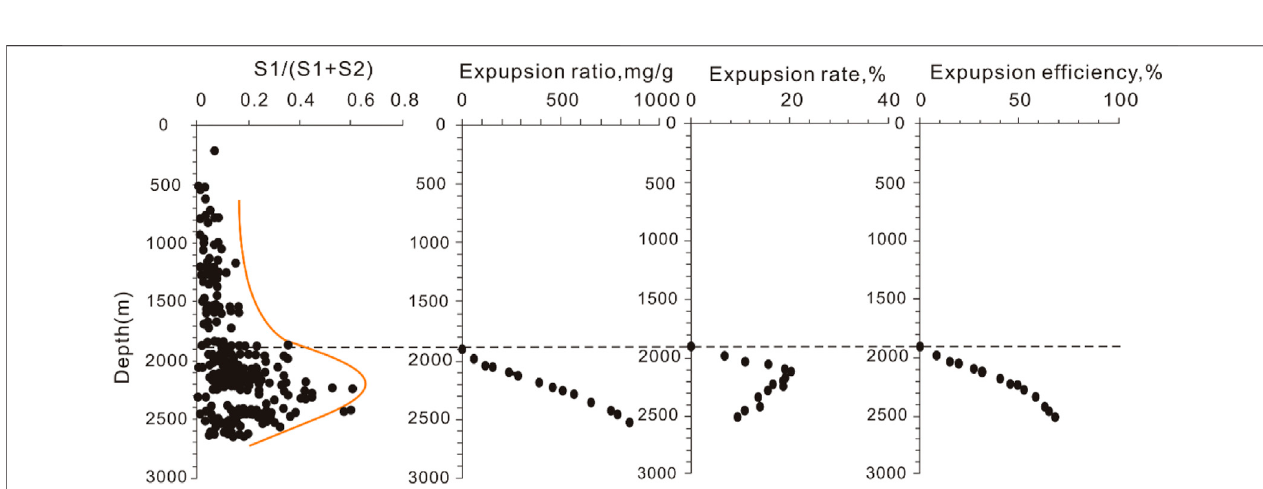
FIGURE 10 | Shale oil expulsion model of the K2qn1 in the southern part of the Songliao Basin [modi fi ed following Liu et al. (2017)].